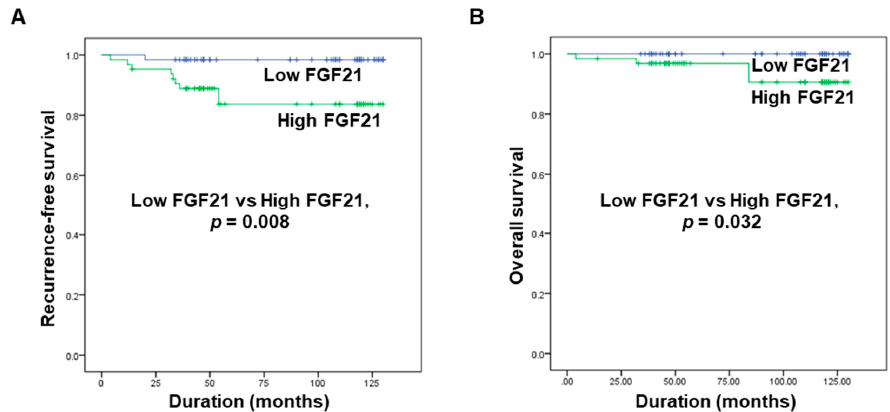
Figure 2. Associations of serum levels of FGF21 with recurrence-free survival and overall survival in patients with PTC. ( A ) Comparison of the five-year recurrence-free survival rate between the high and low FGF21 groups. ( B ) Comparison of overall survival between the high and low FGF21